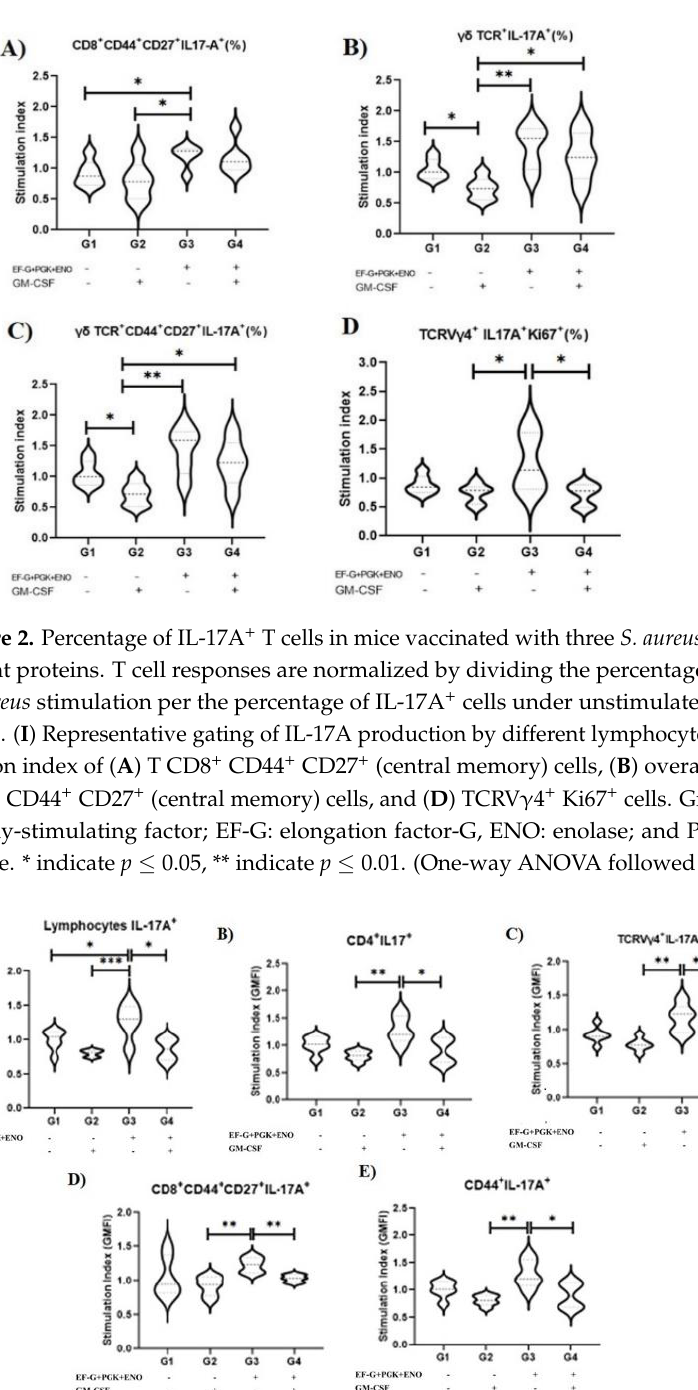
( C ) Figure 4. Percentage of T CD4 + cells in immunized animals, and the antidromic trend of the percent- age TCRVγ4 + effector and central memory cells in mice vaccinated with GM-CSF DNA vaccine. ( A ) Overall T CD4 + , ( B ) TCRVγ4 + CD44 + CD27 − (effector memory cells), and ( C ) TCRVγ4 + CD44 + CD27 + (central memory cells). GM-CSF: Granulocyte-macrophage colony-stimulating factor; EF-G: elonga- tion factor-G, ENO: enolase; and PGK: phosphoglycerate kinase. * Indicate p ≤ 0.05, ** indicate p ≤ 0.01. (One-way ANOVA followed by Tukey test). 3.2. Animals Immunized with Three Recombinant Proteins in Association with the GM-CSF DNA Vaccine Was Associated an Anti-Inflammatory Cytokines Production No effect of immunization on the levels of IL-2 and IL-4 cytokines was observed. The levels of IL-6 ( p = 0.06) tend to be lower upon stimulation with S. aureus than unstimulated control just in immunized animals with the three recombinant proteins and the GM-CSF DNA vaccine (Supplementary Figure S1); however, no significant difference among groups was observed under unstimulated control ( p = 0.79) and S. aureus ( p = 0.68) stimu- lation conditions. The concentrations of IL-10, IL-17A, TNF- α and IFN - γ were below the limit of the detection. 4. Discussion We should highlight that our previous study has already shown that specific anti- bodies (humoral immunity) against the three S. aureus proteins used here are related to the cure of existing IMIs by S. aureus after vaccination with a commercial (bacterin) vac- cine [7]. However, humoral immunity alone may not provide adequate protection against